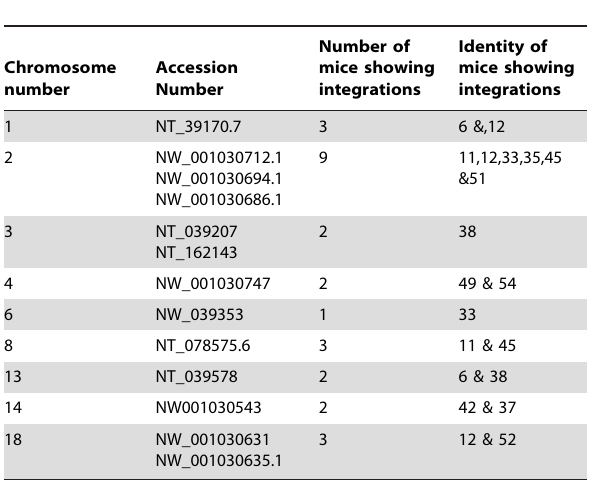
Table 2. Summary of the integration events observed in the different transgenic